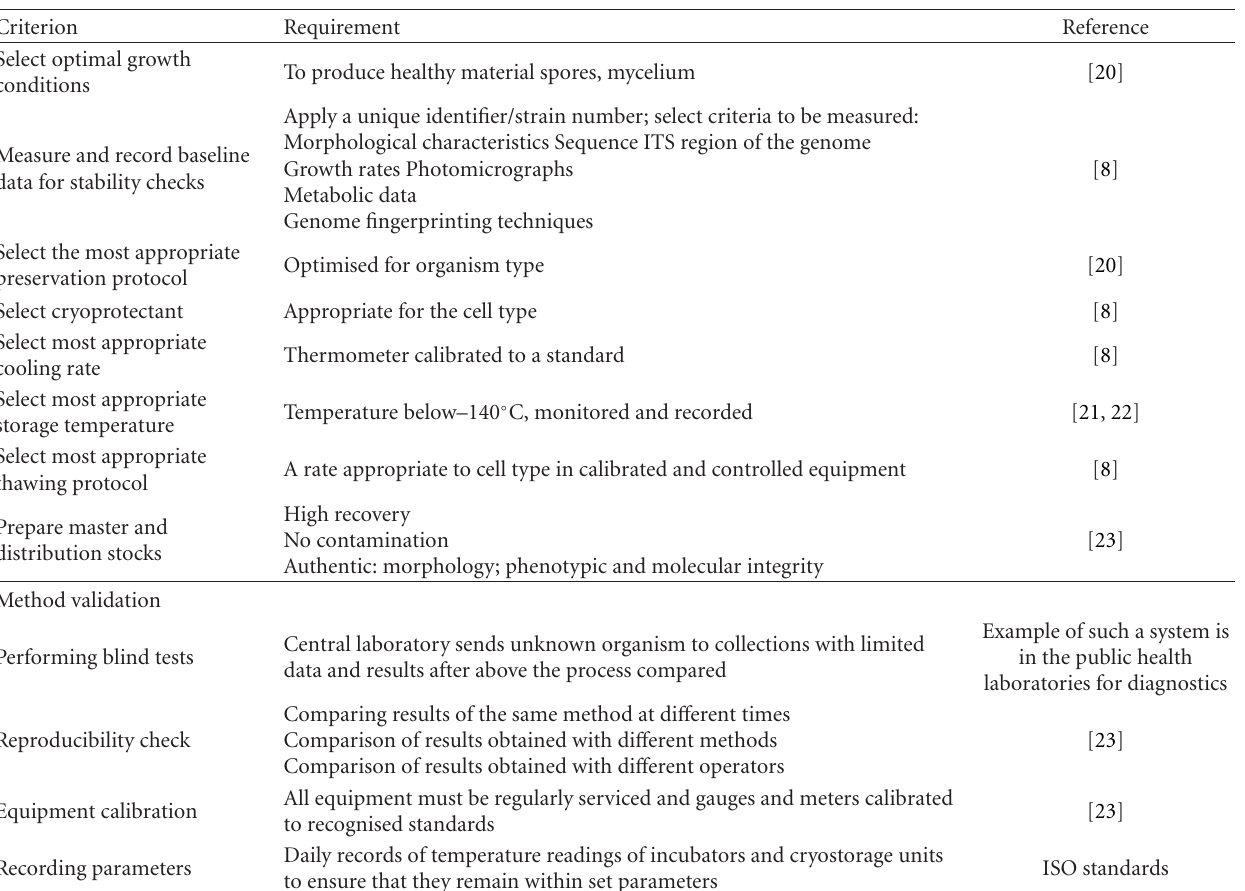
Table 3: Validation of fungal cryopreservation